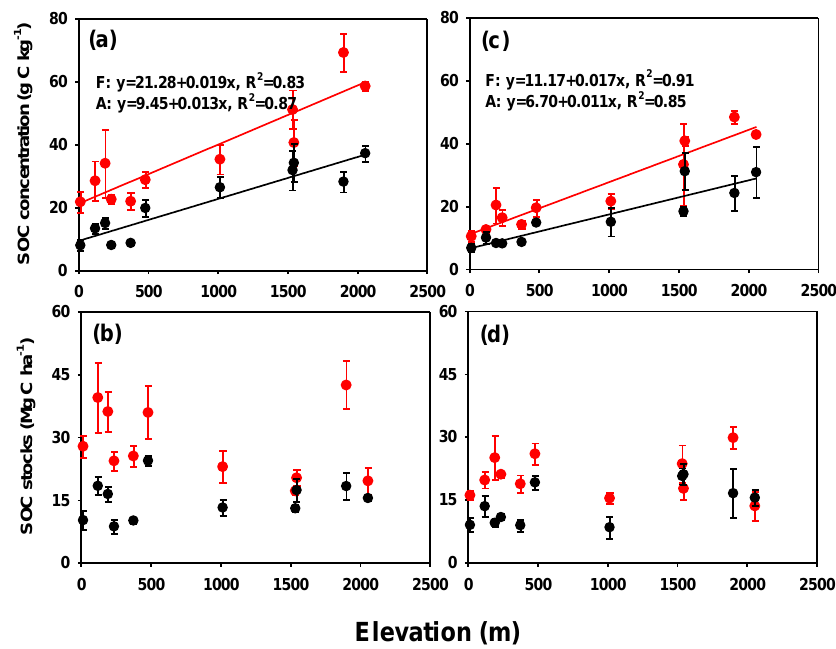
Figure 3. Relationships of soil organic carbon (SOC) concentrations and stocks with elevation in forest regenerated (F) and adjacent agricultural (A) fields at 0–10 cm (surface; a , b ) and 10–20 cm (subsurface; c , d ). Red circles and red lines represent the data obtained from F soil samples. Black circles and black lines represent the data obtained from A soil samples.